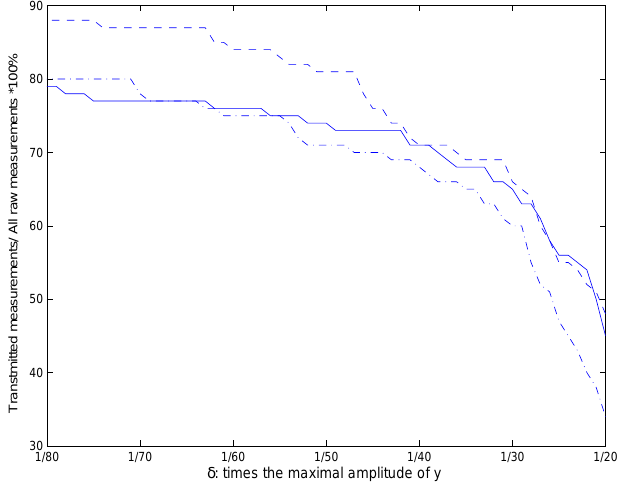
Percentage of transmitted samples to total samples in relation to (cid:14) event-triggered